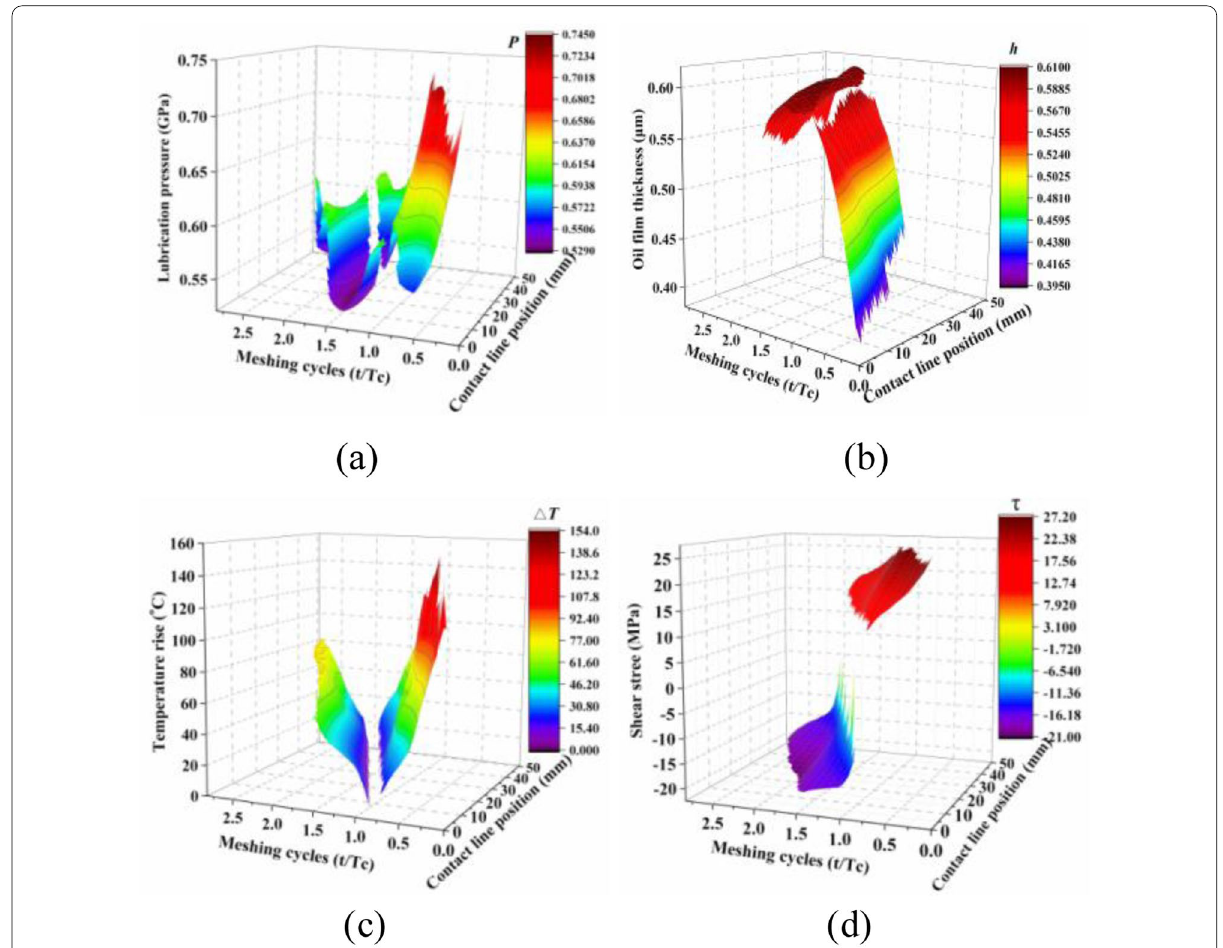
Figure 10 Lubrication characteristics of double involute